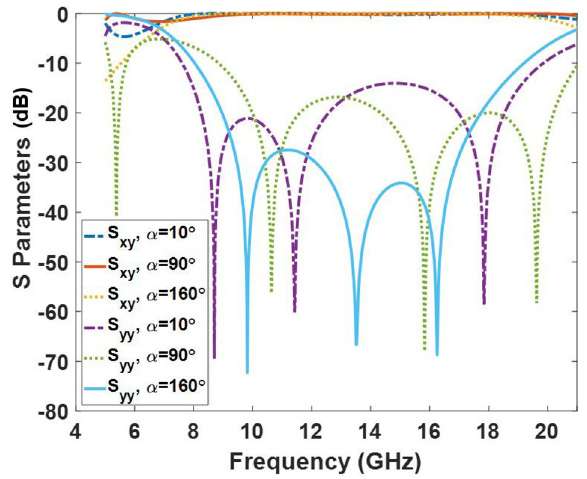
Figure 4. Co- and Cross-polarization conversion coefficients of the element for various values of α . In this plot β = 45 ◦ . The parameters w and r are determined from Fig. 3. The quantities S xy and S yy are the reflection coefficients of the x- and y-polarized waves under the illumination of the y-polarized wave,